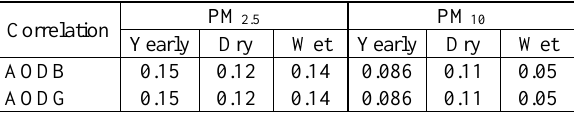
Table 1. Correlation coefficient (Pearson) of AODB and AODG with PM 2.5 and PM 10 .